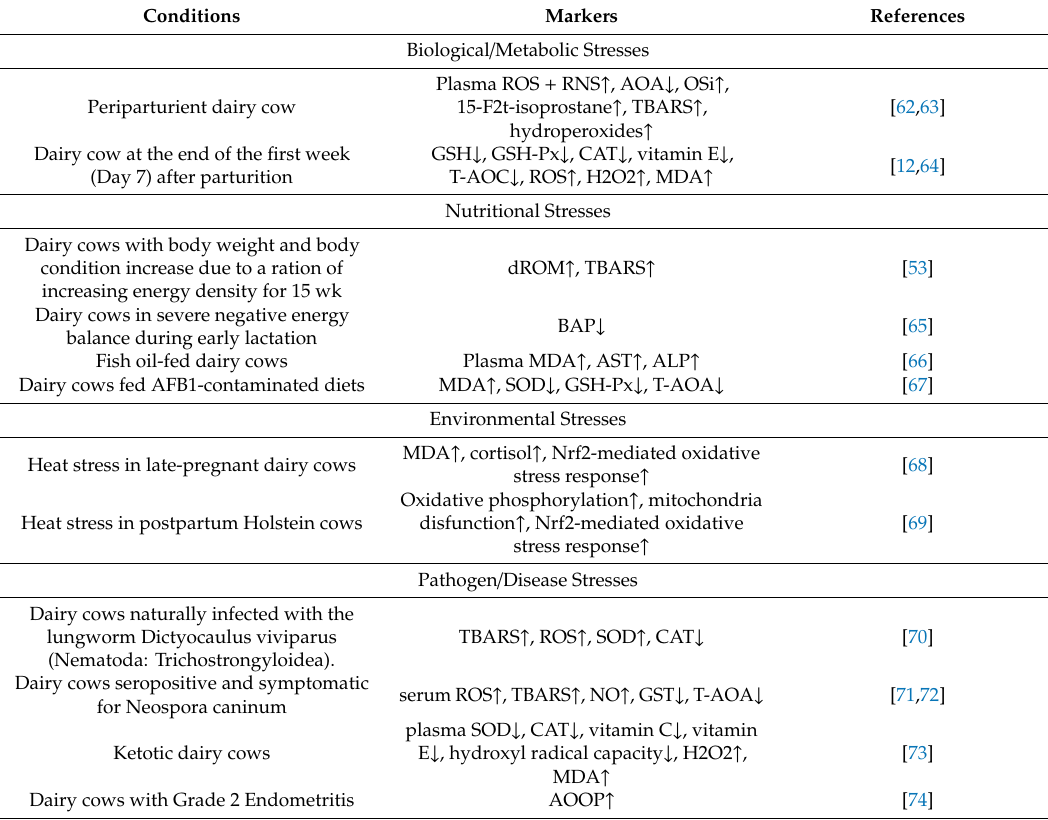
Table 3. Important e ff ectors of oxidative stress in dairy